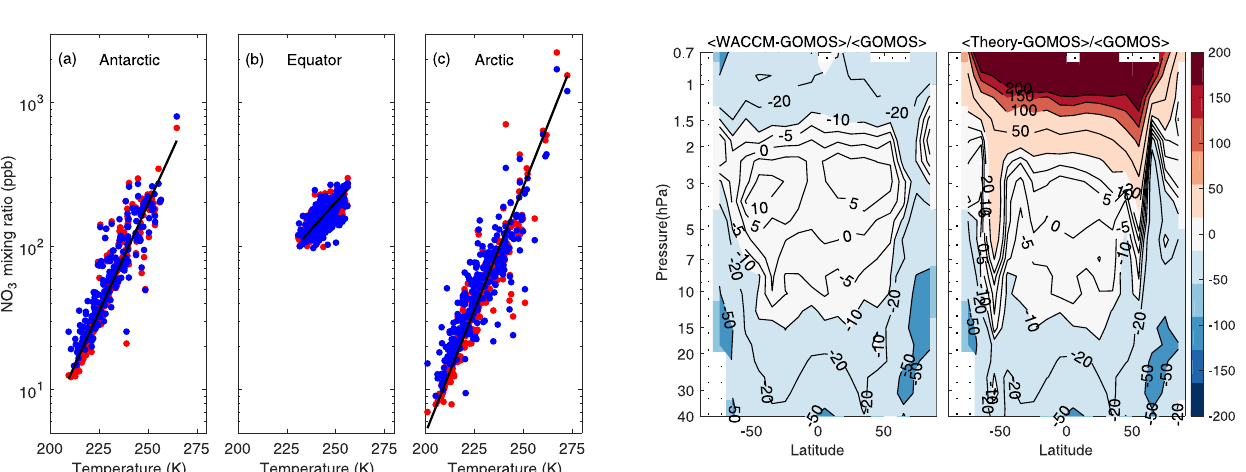
Figure 19. NO 3 –temperature scatter plot at 3.7hPa. (a) The Antarc- tic 60–90 ◦ S. (b) The Equator 10 ◦ S–10 ◦ N. (c) The Arctic 60– 90 ◦ N. Red dots are from WACCM and blue dots from GOMOS. Exponential fits are applied to temperature gridded WACCM data. Data for all latitudes are from 5-day time series from 2002 to 2011.